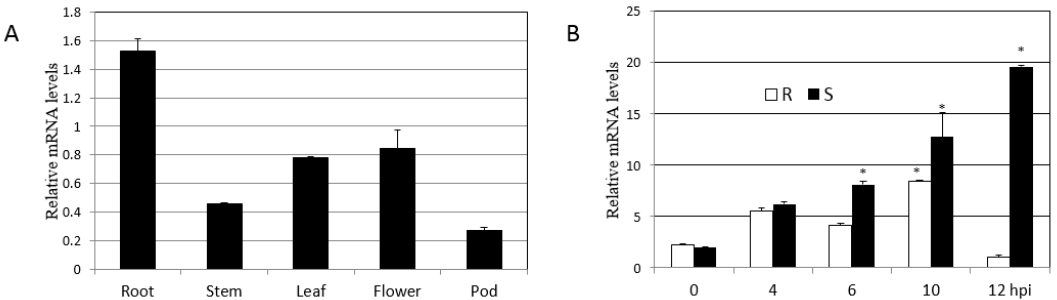
Figure 6. Expression profiling of GmHRLI-1 in soybean by qPCR. ( A ) Relative mRNA level of GmHRLI-1 in di ff erent indicated tissues of the wild-type soybean plant. ( B ) Relative mRNA levels of GmHRLI-1 gene in R (resistance) and S (susceptible) soybean leaf tissue after SMV infection at 0, 4, 6, 10, and 12 hpi (hours post-inoculation). Error bars indicate SD (n = 3). Asterisks denote significant di ff erence from the 0 time point, as determined by the t -test, P < 0.001. Each result is representative of three biological repeats.